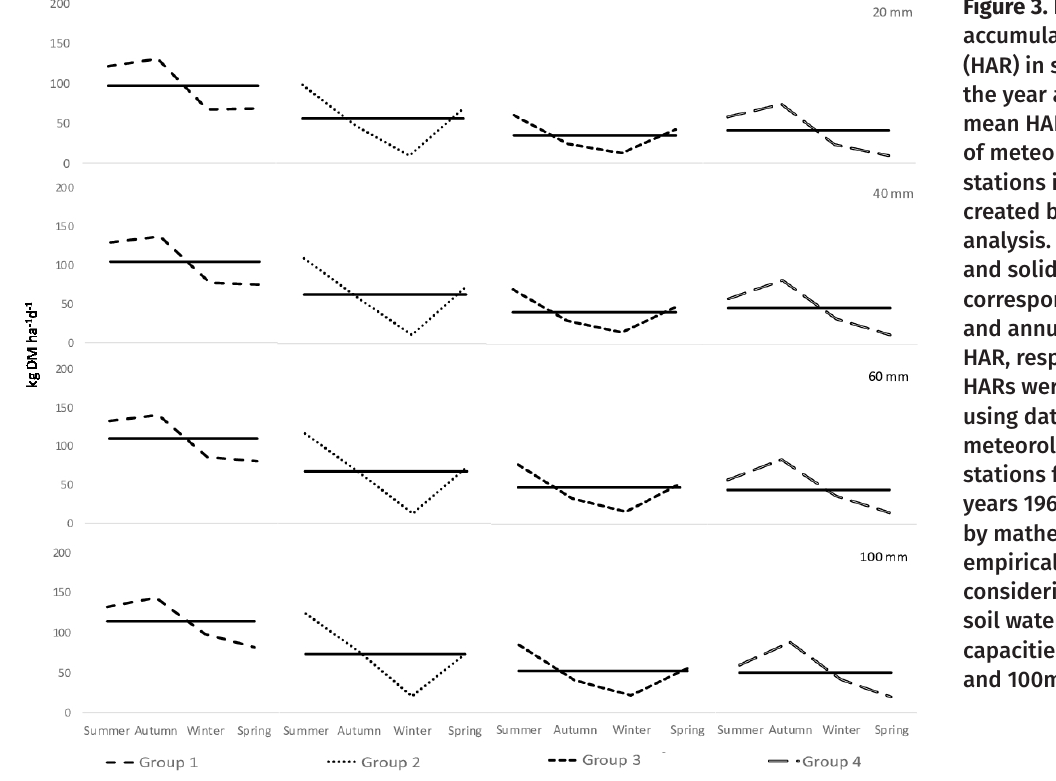
Figure 3. Herbage accumulation rate (HAR) in seasons of the year and annual mean HAR of Groups of meteorological stations in Brazil, created by cluster analysis. Dashed and solid lines correspond to